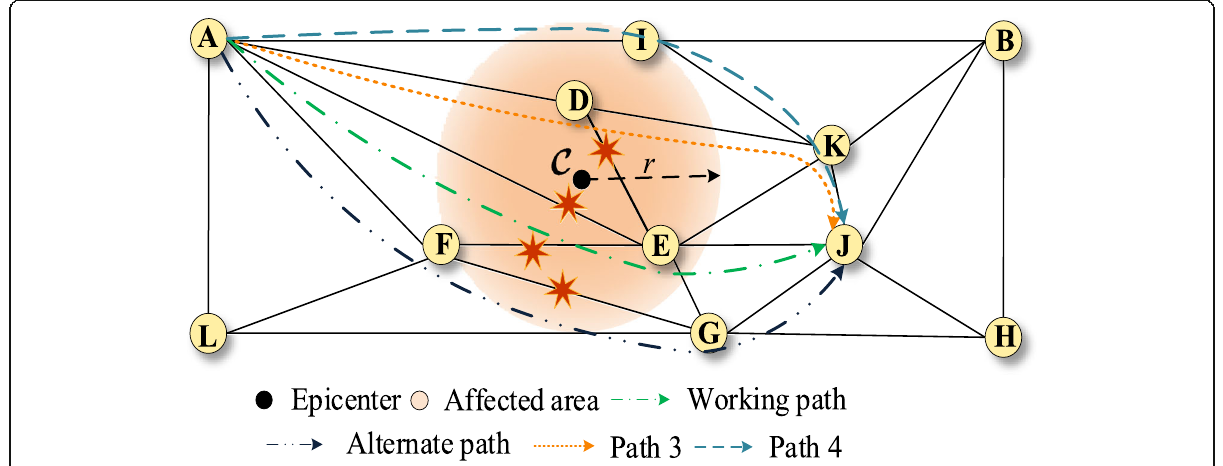
Fig. 4 Schematic of higher survival path. This figure is an example of finding the available path with higher survivability for